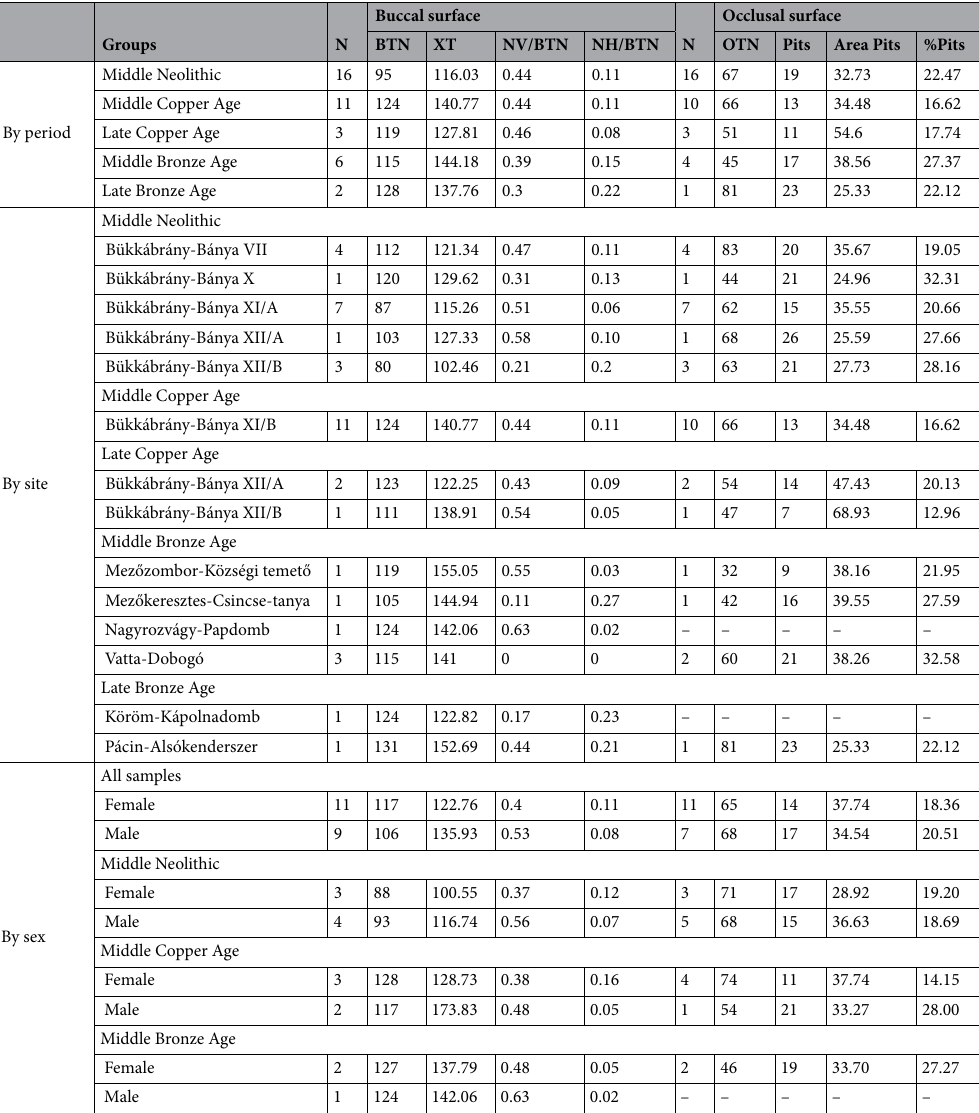
Table 4. Summary of microwear results of human individuals included in this study. N total number of adult individuals (see text for explanation; *number of adult individuals when comparing by period and site); BTN number of striations on the buccal surface; XT length of striations in µm; NV/BTN vertical index; NH/BTN horizontal index; OTN total number of striations in the occlusal surface; %Pits percentage of